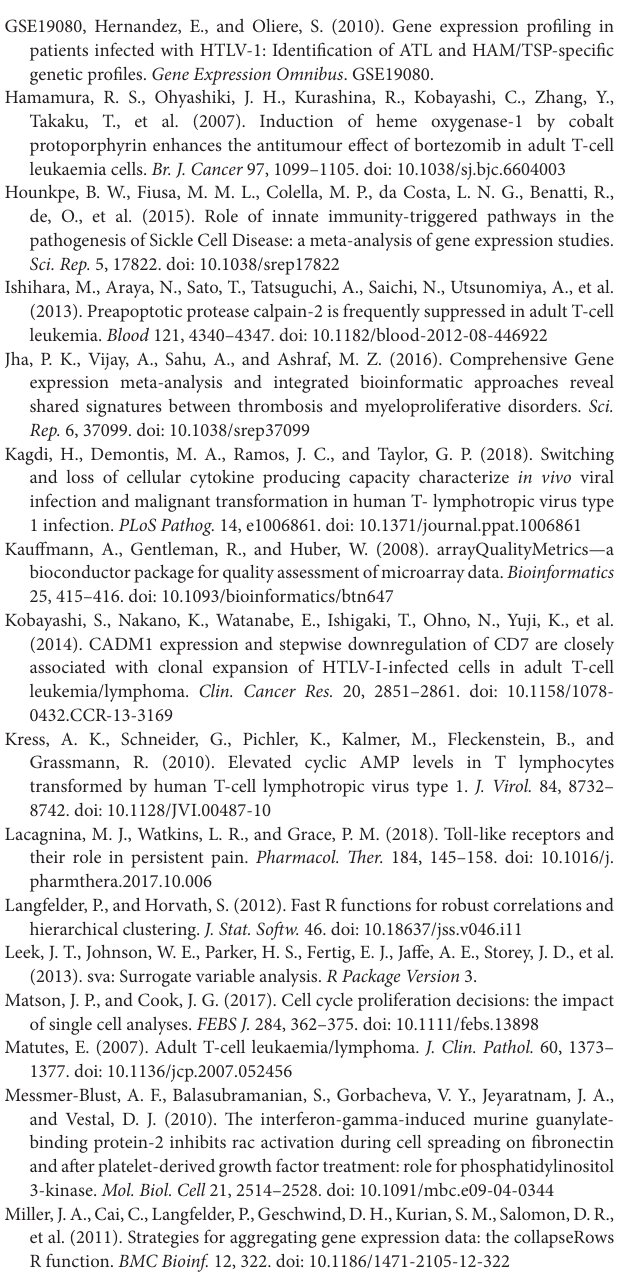
TABLE S2 | Correlations observed between CD40LG and GBP2 in the HAM/ TSP group. TABLE S3 | Correlations observed between CD40LG and GBP2 in the ATLL group. TABLE S4 | Correlations observed between CD40LG and GBP2 in the control group. TABLE S5 | Detailed information regarding the negatively correlated pathways and associated genes (ENTREZ ID). TABLE S6 | Detailed information regarding the positively correlated pathways and associated genes (ENTREZ ID).